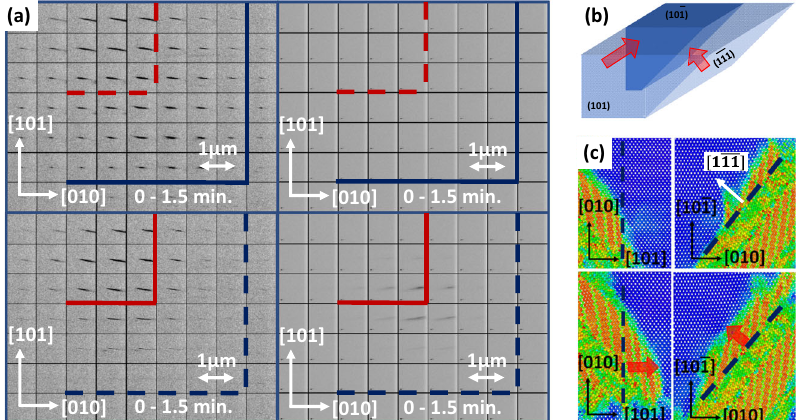
Fig. 4 Shifts of Si-I/Si-II interfaces as observed by in situ real-time Laue diffraction and MD simulation. a Maps of 202 re fl ection from a Si-I crystal (left column) and maps of a diffuse re fl ection from Si-II (right column). More maps are available in the Supplementary Movie 1. b 3D schematic of the shifts of the Si-I/Si-II interfaces. c Simulated shifts of the Si-I/Si-II interfaces. In all the images the interfaces before the shifts are shown by dark blue and the interfaces after the shifts are shown by red lines; solid lines denote currently existing interfaces and dotted dashed lines denote interfaces existing in different states; directions of the shifts of the interfaces are shown by red